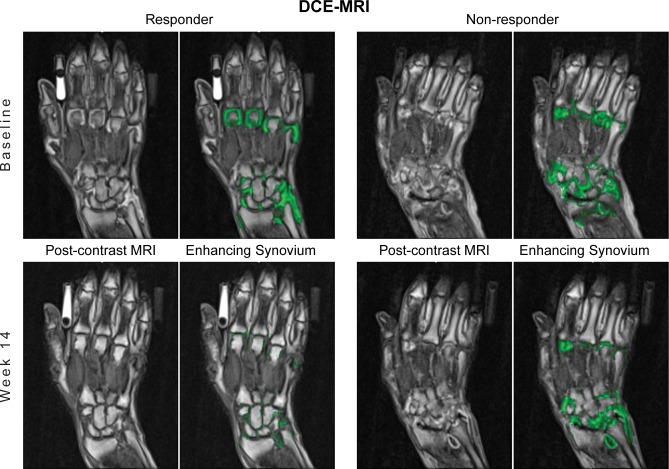
Baseline vs Week 14 DCE-MRI.Enhancing Synovium (green regions of interest) decreased dramatically from baseline to Week 14 in a clinical responder treated with infliximab (left), but was largely unchanged in a non-responder treated with placebo (right). Responder was defined as change from baseline in DAS28(CRP) >1.2 and non-responder as <0.6.